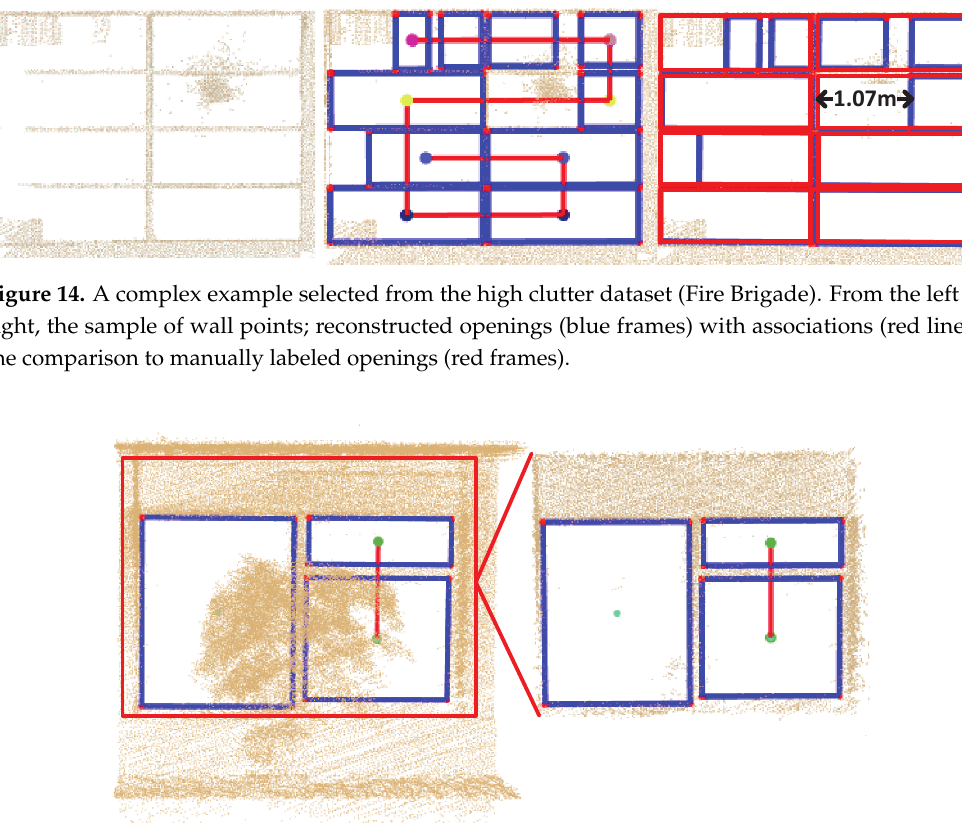
Figure 15. An occlusion by a tree. The red line between the two green dots demonstrates the association of the two openings. The red frame emphasizes the window part of the